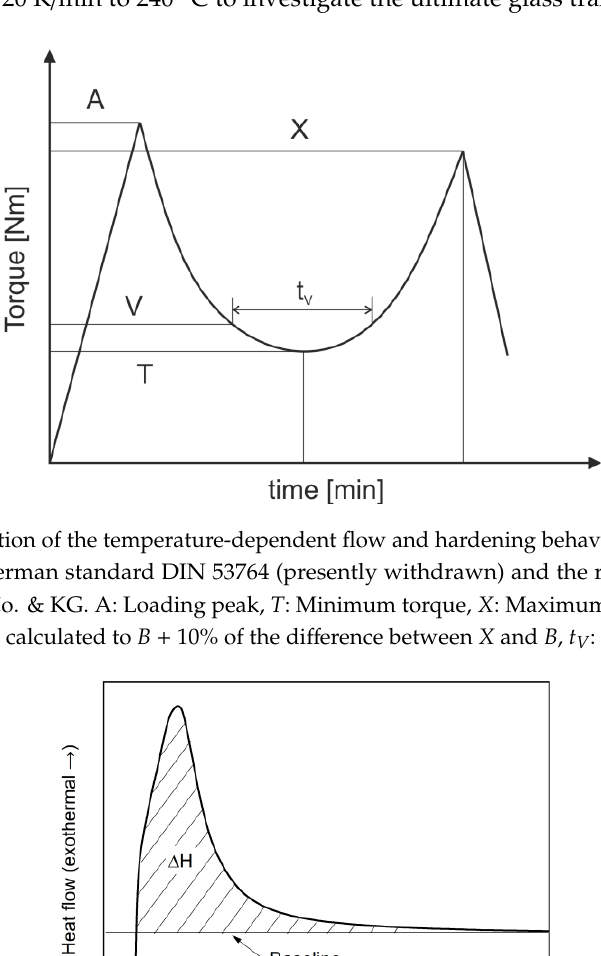
Figure 2. Pictures of measuring mixer ( a ) mixer bowl with an opening on the top to fill testing material ( b ) mixing blades on the rear site.